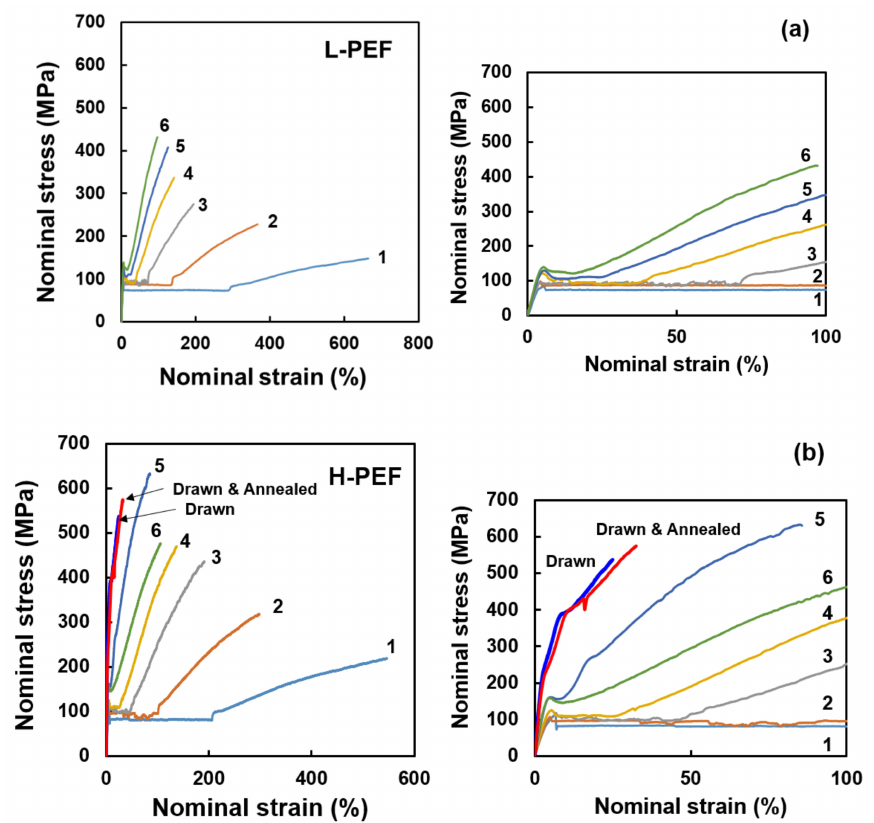
Figure 8. Stress–strain (s–s) curves of high-speed spun ( a ) L-PEF and ( b ) H-PEF fibers obtained at various take-up velocities. The results for the drawn and the drawn and annealed fibers are included for comparison. Enlarged s–s curves for the initial stage of stretching are also shown.